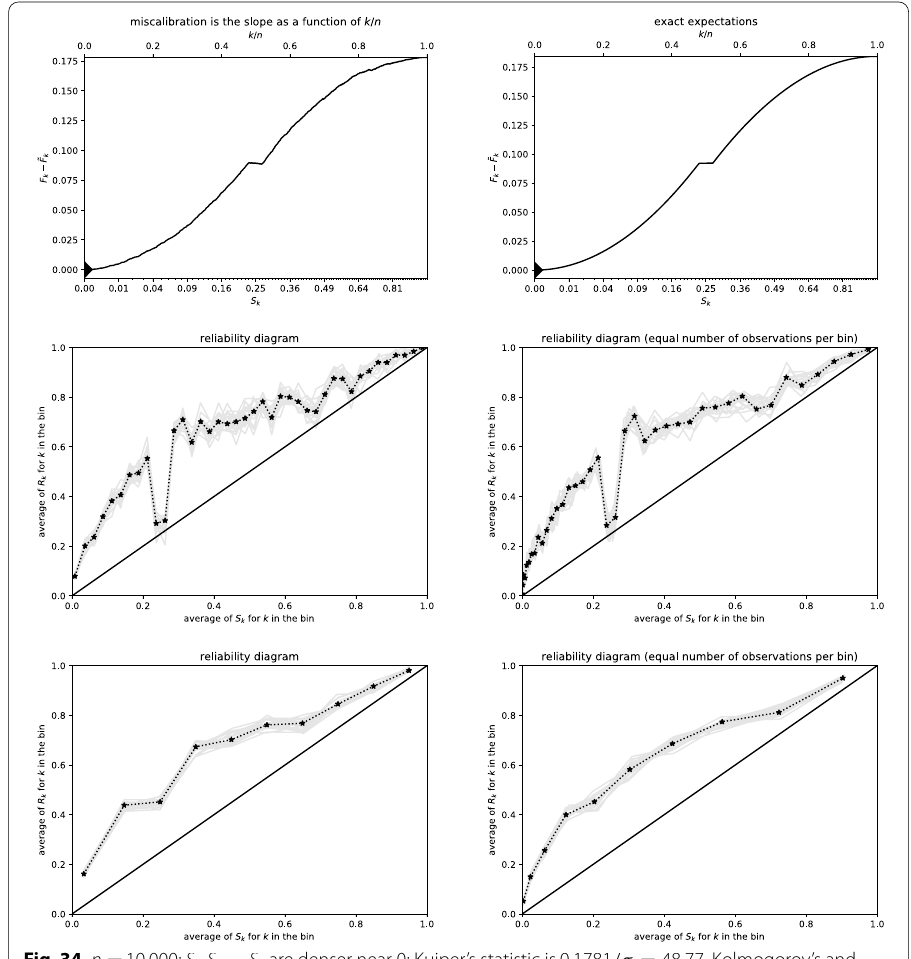
Fig. 34 n = 10,000; S 1 , S 2 , ..., S n are denser near 0; Kuiper’s statistic is 0.1781 /σ = 48.77 , Kolmogorov’s and Smirnov’s is 0.1781 /σ = 48.77 . Figure 35 displays the ground-truth reliability diagram. All plots, whether cumulative or conventional, work well enough, though the reliability diagrams might be